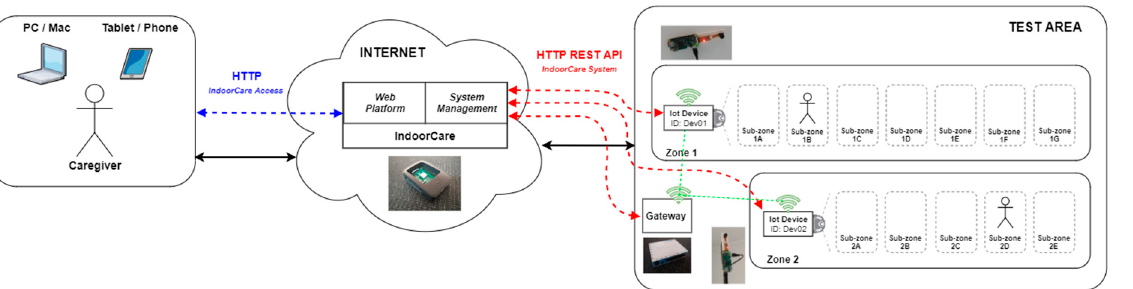
Figure 4. Raspberry PI Zero W #1 ( a ) and #2 ( b ).